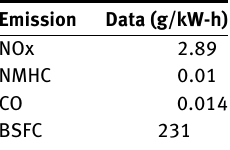
Table 7: Final results for single injection optimization. Emission Data (g/kW-h)